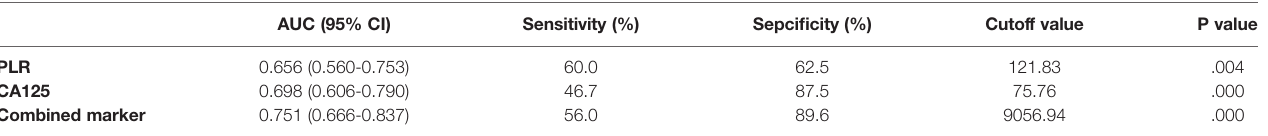
CI, con fi dence interval; PLR, platelet-to-lymphocyte ratio; Combined marker, the CA125 level multiplied by the PLR. *P <.05 was considered statistically signi fi cant.